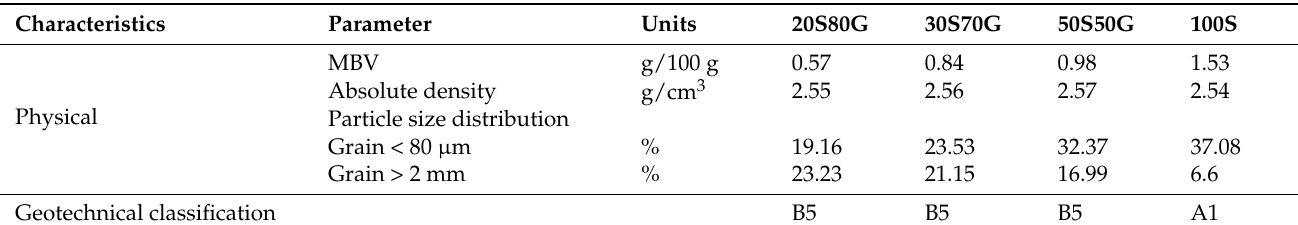
Table 4. Mix physical characteristics and geotechnical